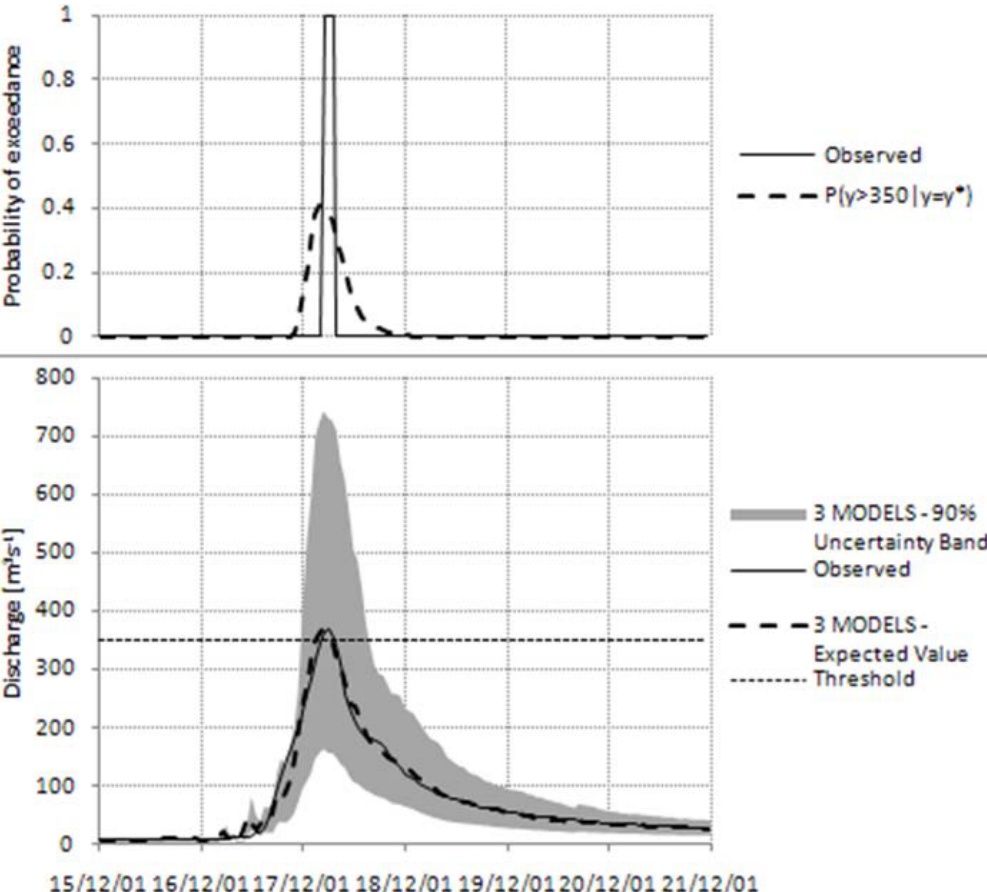
Fig. 17. Flood event for the calibration period. The lower panel represents the discharge forecast; observed values (continuous line); ex- pected value conditioned to the TOPKAPI, TETIS and ANN forecasts (dashed line); 90% uncertainty band (grey area); alarm threshold of 350m 3 s − 1 (small dashed line). The upper panel represents the probability of exceeding the alarm threshold; observed binary response (continuous line) and Probability of exceeding the threshold computed by the MCP (dashed line).